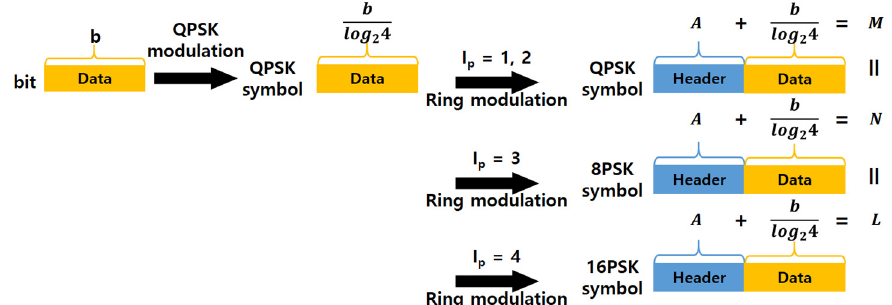
Figure 8. Proposed header and data separated symbol transformation process.